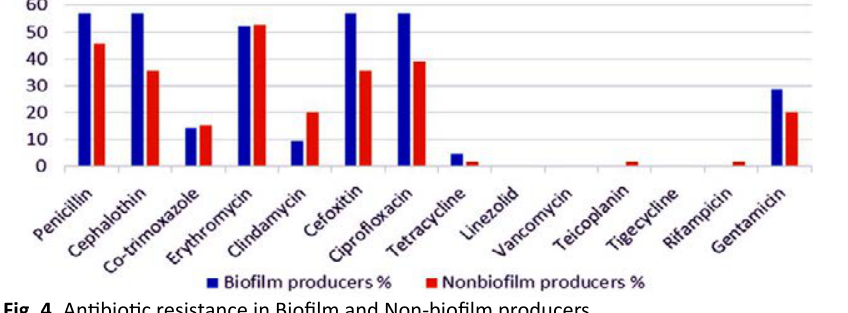
Fig. 4. Antibiotic resistance in Biofilm and Non-biofilm